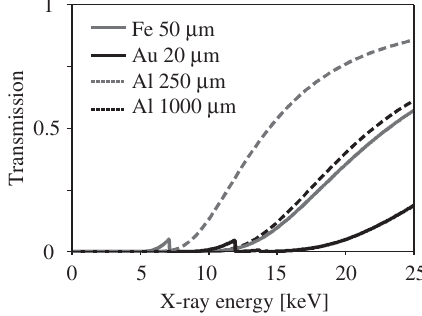
FIG. 4. Spectral transmission of filters used in the experiment, per Ref. [39]. Absorption along the 0.5 m air path and the 2 × 250 μ m thick Be vacuum windows is included.